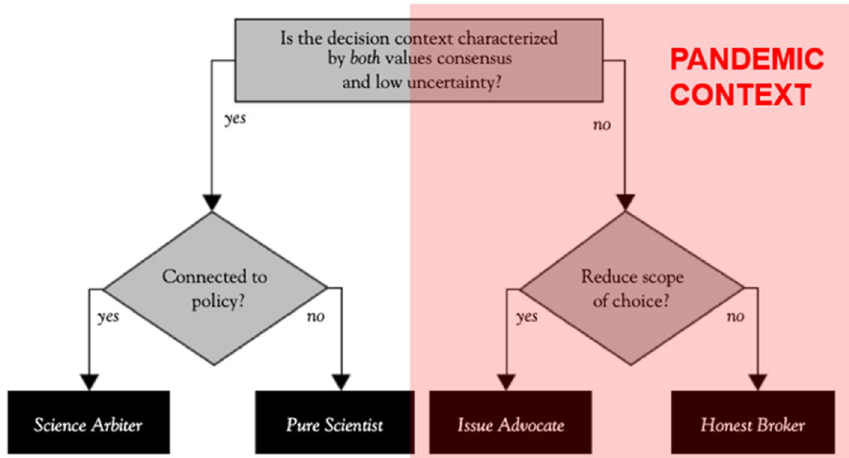
Fig. 7 Criteria for determining the roles of science in policy and